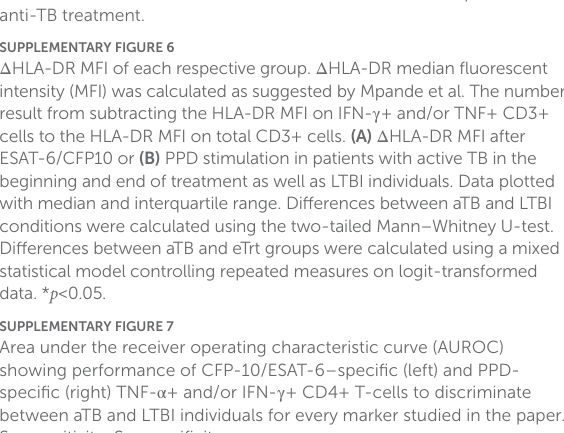
SUPPLEMENTARY FIGURE 7 Area under the receiver operating characteristic curve (AUROC) showing performance of CFP-10/ESAT-6–specific (left) and PPD- specific (right) TNF- α + and/or IFN- γ + CD4+ T-cells to discriminate between aTB and LTBI individuals for every marker studied in the paper. Se, sensitivity; Sp,